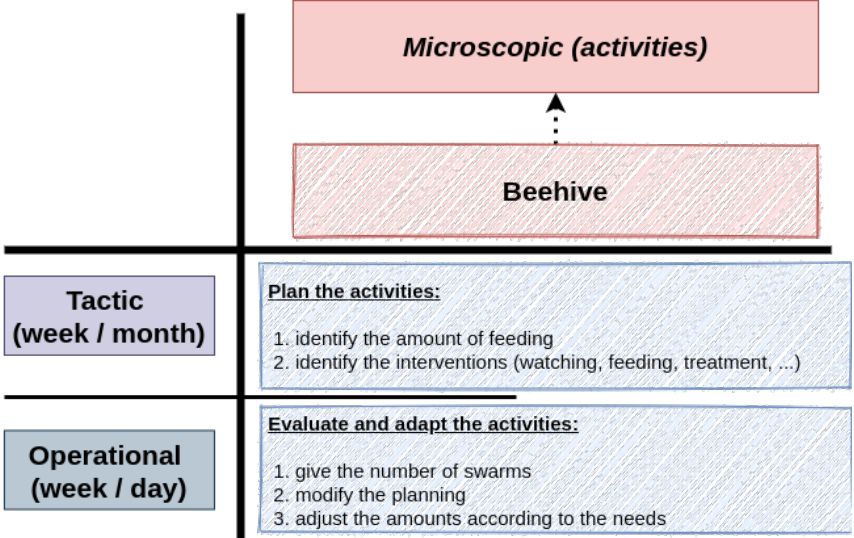
Figure 3. Application of the spatio-temporal matrix to the beekeeping